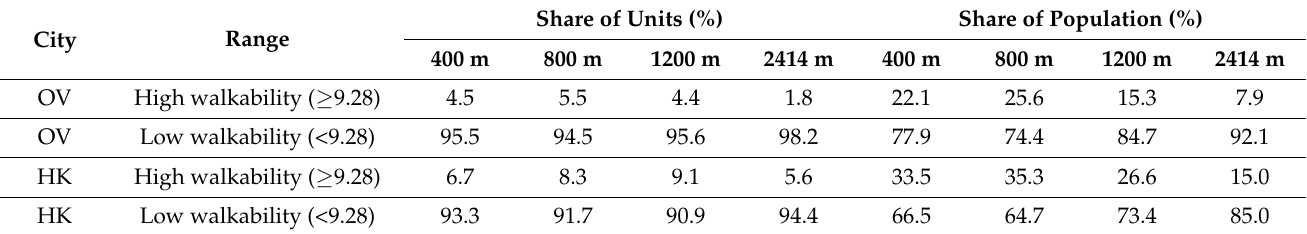
Table 2. Distribution of WAI for different search radii in Ostrava (OV) and Hradec Kralove